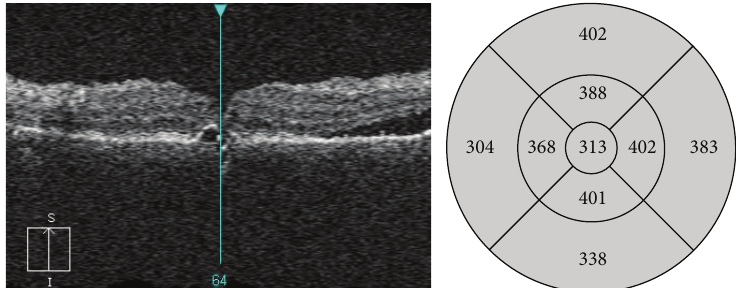
Figure 1: OCT scan of the patient with chronic central serous chorioretinopathy before SDM treatment. General retinal thickening present in the fovea together with small PED. Subretinal fluid present in the superior part of the macula.